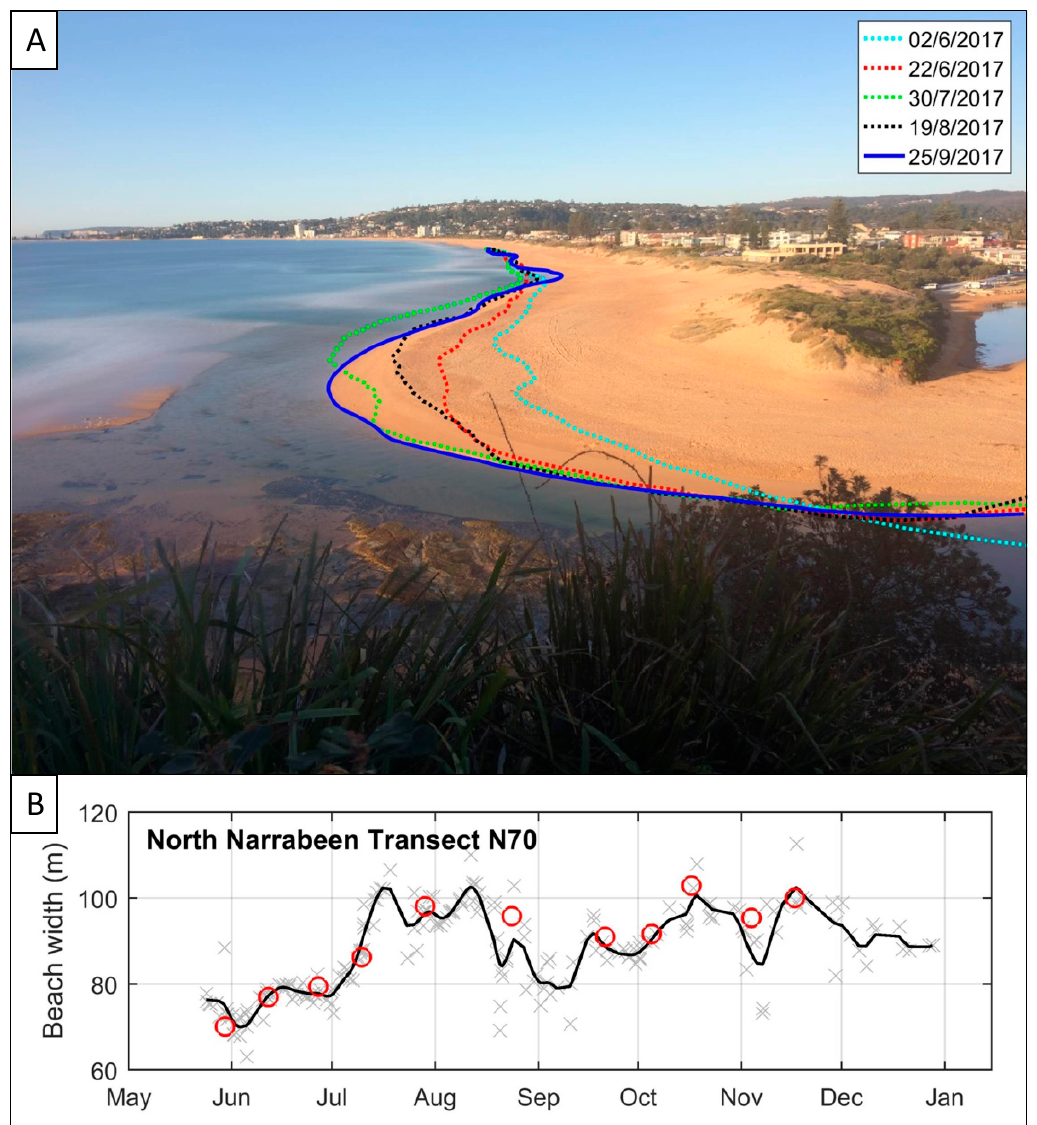
Figure 8. ( A ) Example figure showing shoreline change at North Narrabeen over a 3-month period 06/17–12/17. ( B ) Comparison of CoastSnap derived shorelines (grey and solid black line) to in-situ surveys (red dots).